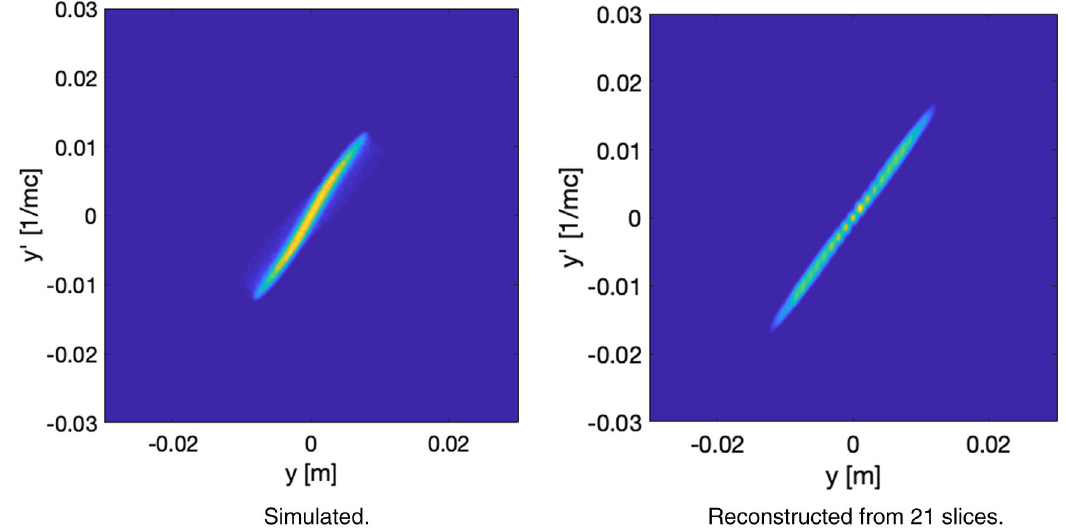
FIG. 10. Vertical uncorrelated phase space, (left) simulated, (right)